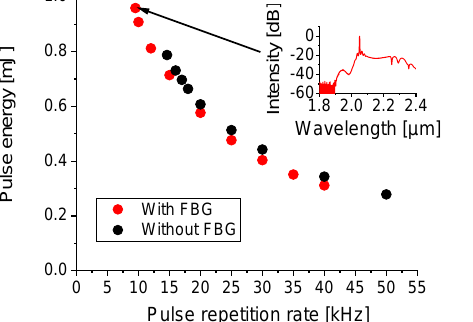
Figure 1: Pulse energy versus PRR of the fiber laser with and without FBG. For the highest pulse energy of 960 µJ a SC appears in the output spectrum.